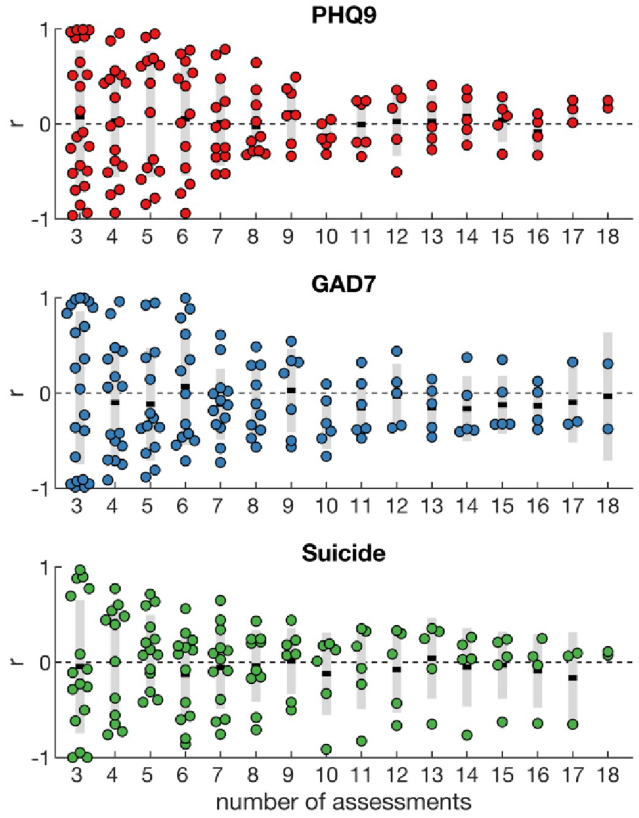
Fig 4. Intra-individual correlations. Group-level regression models were used to predict intra-individual changes in symptoms. The predicted mental health scores were correlated with the observed mental health scores for each participant. The coloured dots show the correlation coefficients for individual participants, the black line the group mean and the grey bars the 95% CI. The distribution of correlation coefficients was estimated for all participants having completed at least 3 to 18 assessments. The number of participants decreased with increasing number of assessments, as participants did not complete all assessments (see Fig 1B).